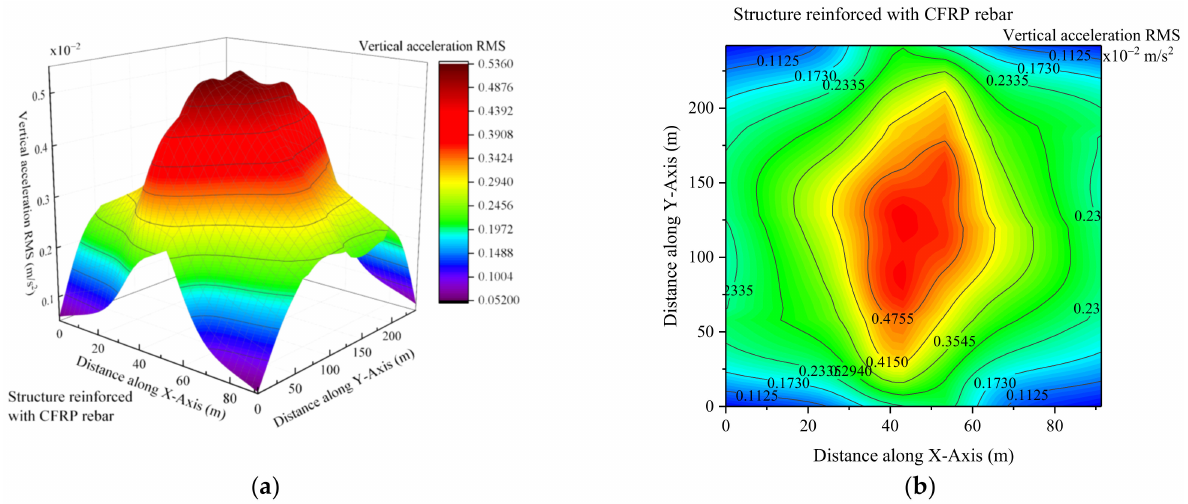
Figure 17. Color chart of the vibration RMS for the structure reinforced with CFRP rebar. ( a ) 3D diagram; ( b ) vertical